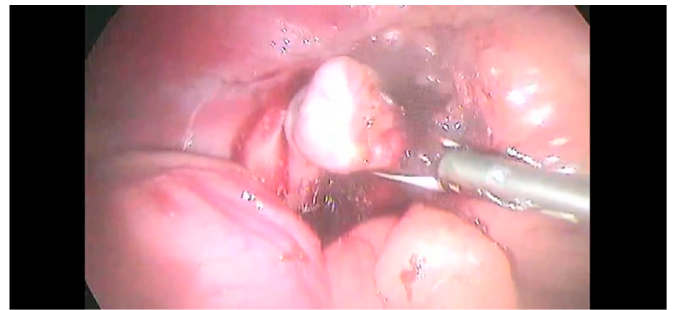
Figure 4. The phrenicoabdominal (PA) vein and artery were identified and sealed using a sealing device.